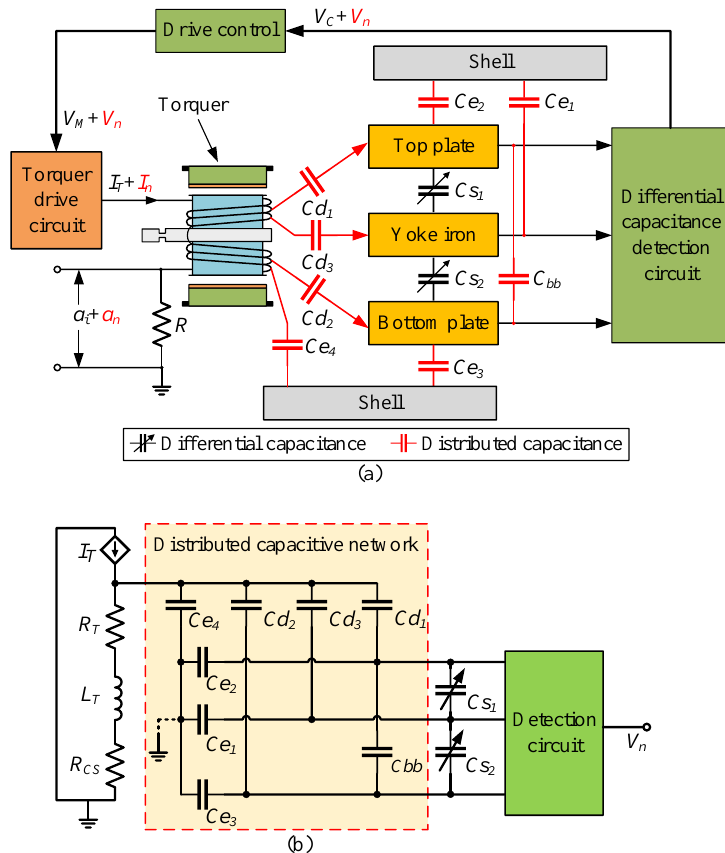
Figure 2. ( a ) Schematic diagram of distributed capacitance among various components of QFA; ( b ) Equivalent circuit model of electric field coupling detection noise in QFA.